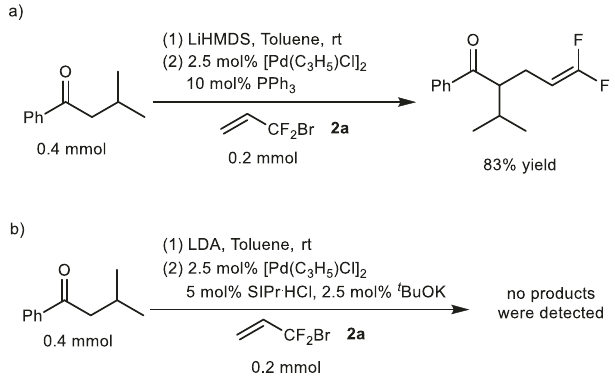
Fig. 3 Pd-Catalyzed reaction of ketone with BDFP. a Palladium-catalyzed reaction of ketone with BDFP with PPh 3 as the ligand. b Palladium-catalyzed reaction of ketone with BDFP using NHC as the ligand.